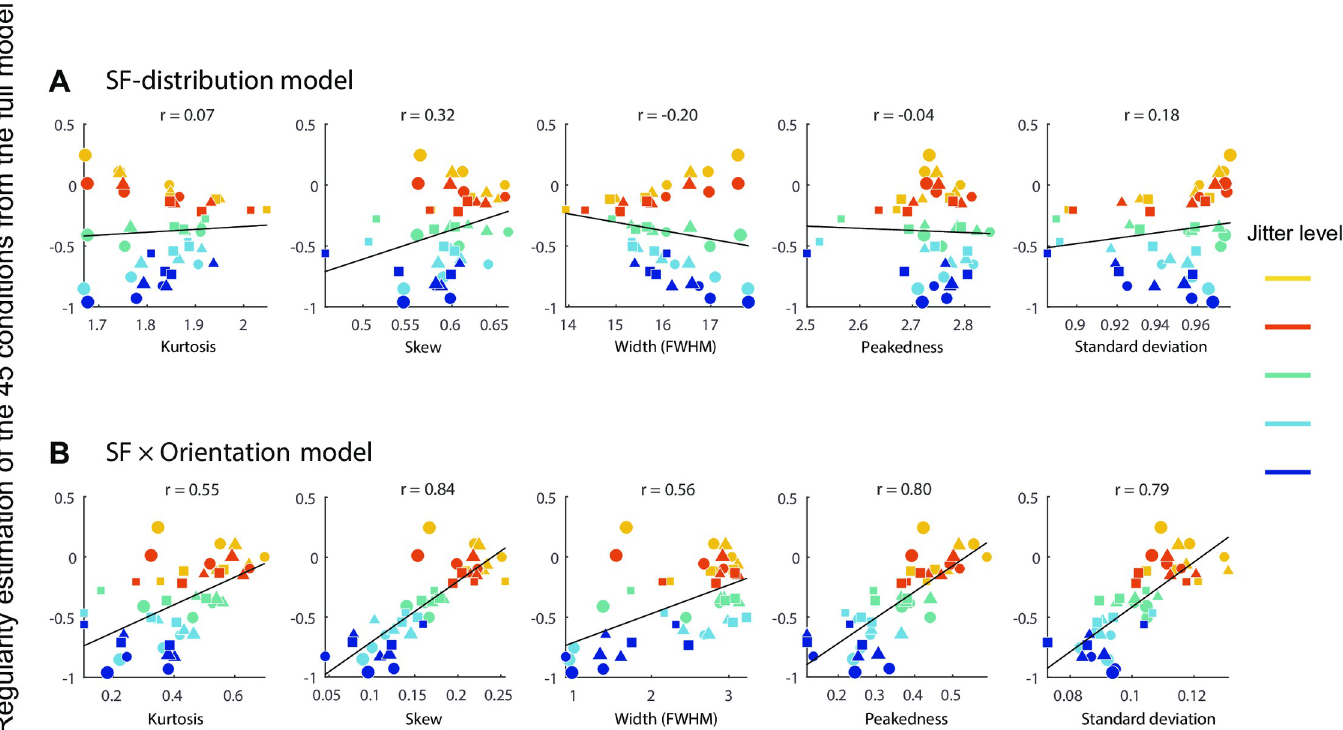
Fig 10. Comparison of SF-distribution model and SF × orientation distribution model in predicting psychophysical results. Perceived regularity estimates for the 45 experimental conditions from the full statistical Model 12 (see S3 Fig) are correlated with five SF-distribution parameters (kurtosis, skew, FWHM, peakedness and standard deviation) from SF-distribution model (A) and another five parameters from SF × orientation distribution model (B). Color codes for the five jitter levels (yellow to blue). The marker size (small to large) corresponds to element size (level 1 to 3), and the marker shape (circle, triangle and square) corresponds to element spacing (level 1 to 3). The SF × orientation distribution model shows stronger correlations with perceived regularity, across all of the five parameters.